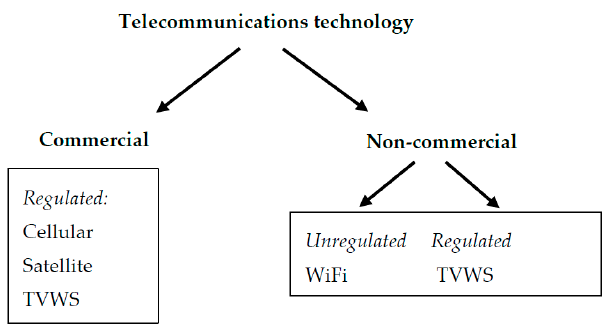
Figure 3. Telecommunications technologies.